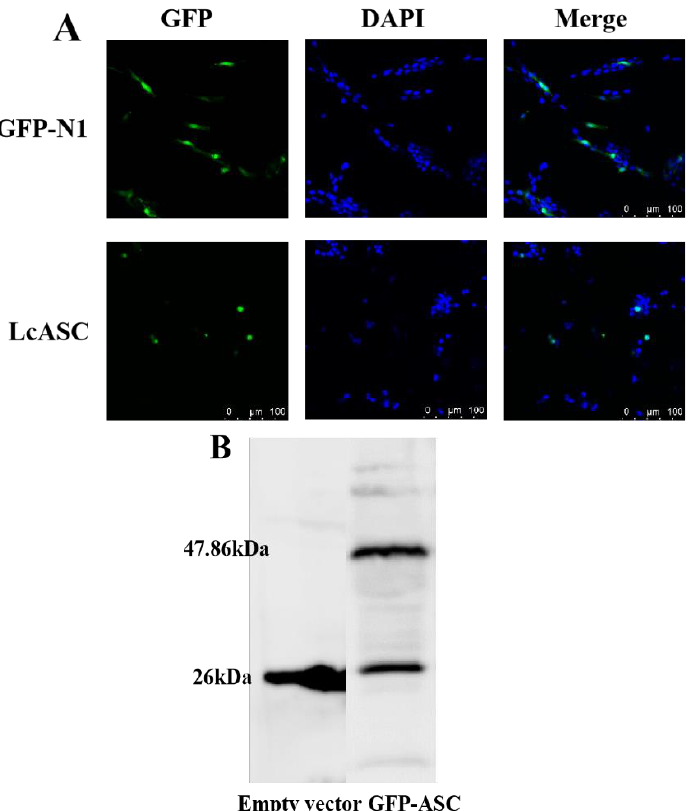
Figure 4. ( A ) Cytoplasmic localization of LcASC protein in large yellow croaker kidney cells. ( B ) The exogenous expression of LcASC protein in large yellow croaker kidney cells confirmed by Western blot using anti-GFP antibody. The cells transfected with GFP-tagged LcASC plasmid show a ~47.86 kDa band, which is absent in control cells transfected with empty vector.